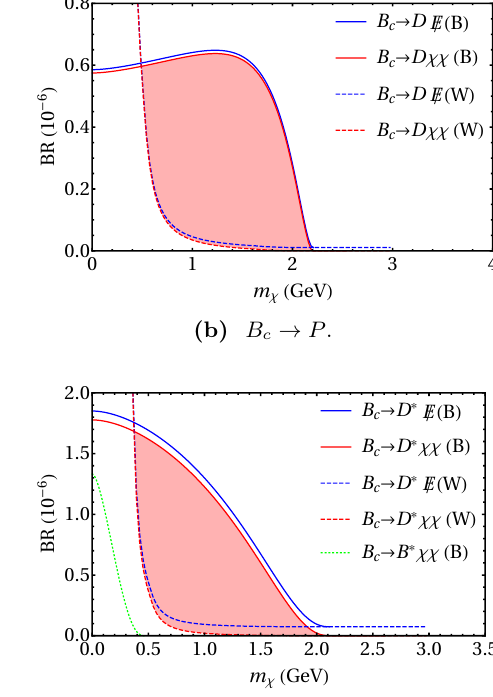
c ! P ( V ) (cid:31)(cid:31)